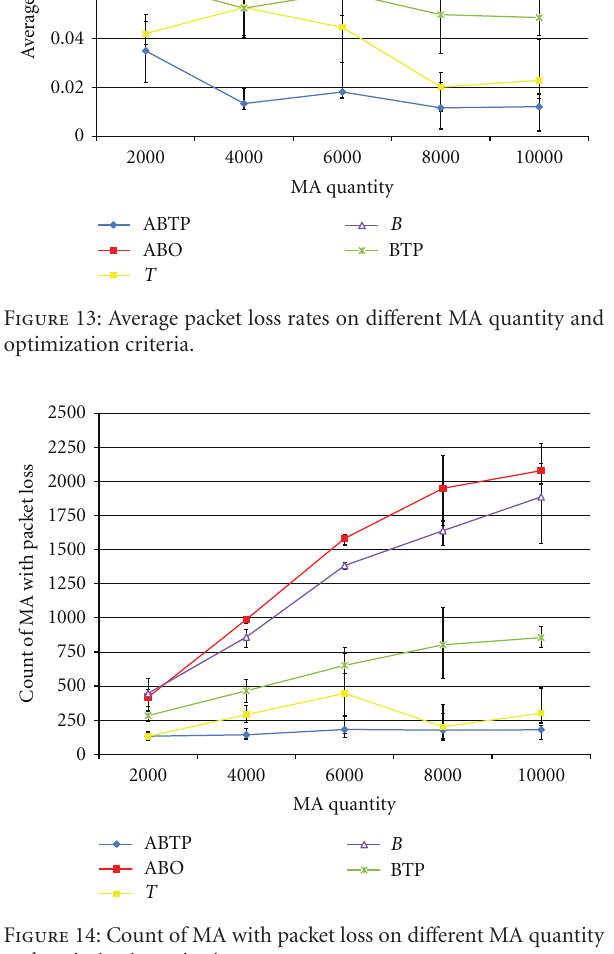
Figure 14: Count of MA with packet loss on di ff erent MA quantity and optimization